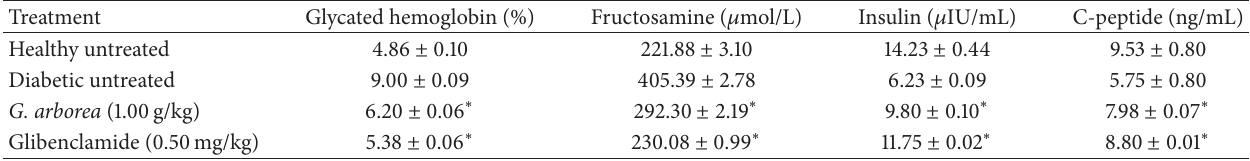
Table 1: Blood/serum glycemic parameters in diabetic rats after 30 days of treatment.